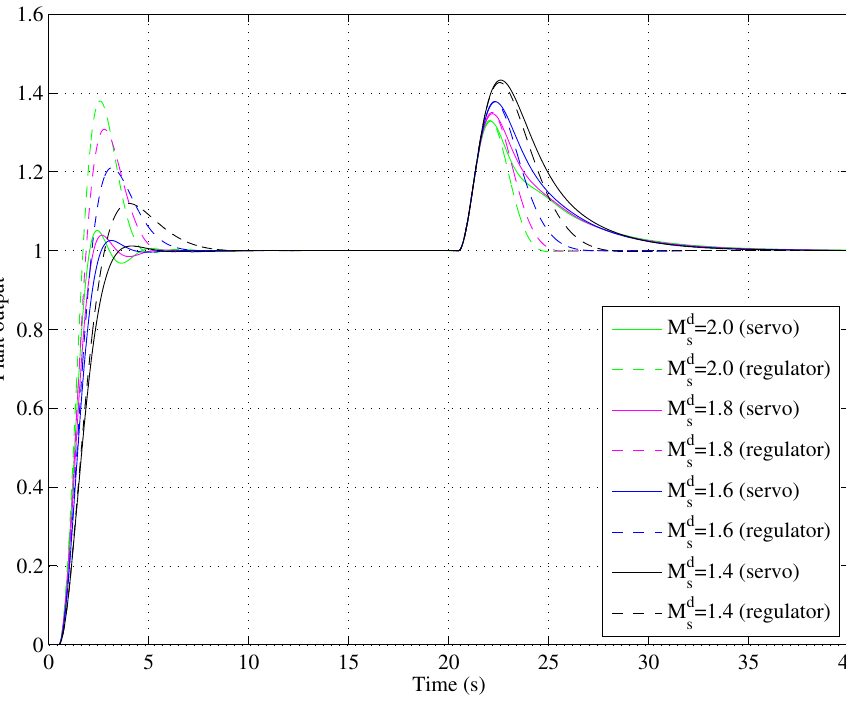
Figure 13. Servo and regulation performances for a =